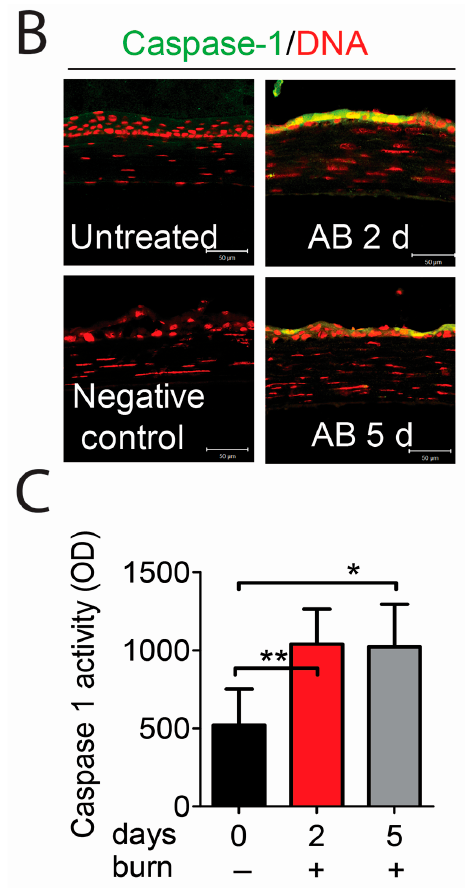
Figure 3. Caspase-1 activation in corneal epithelium in animals subjected to alkali burn (AB) at 2 days (2 d) and 5 days (5 d) post-injury. ( A ) Gene expression analysis of caspase-1 mRNA transcript in whole cornea of animals subjected to alkali burn ( n = 8 animals/group). Graphs show mean ± standard error of the mean (SEM); * p < 0.05. ( B ) Representative merged digital images of laser scanning confocal microscopy in corneal cryosections immunostained for caspase-1 (green) with propidium iodide nuclei counterstaining (DNA in red) in animals subjected to alkali burn ( n = 6 animals/group). Scale bar: 50 µm. ( C ) Caspase-1 activity in whole cornea lysates from eyes subjected to alkali burn ( n = 12 animals/3 samples/group). Graphs show mean ± SEM; * p < 0.05, ** p < 0.01.